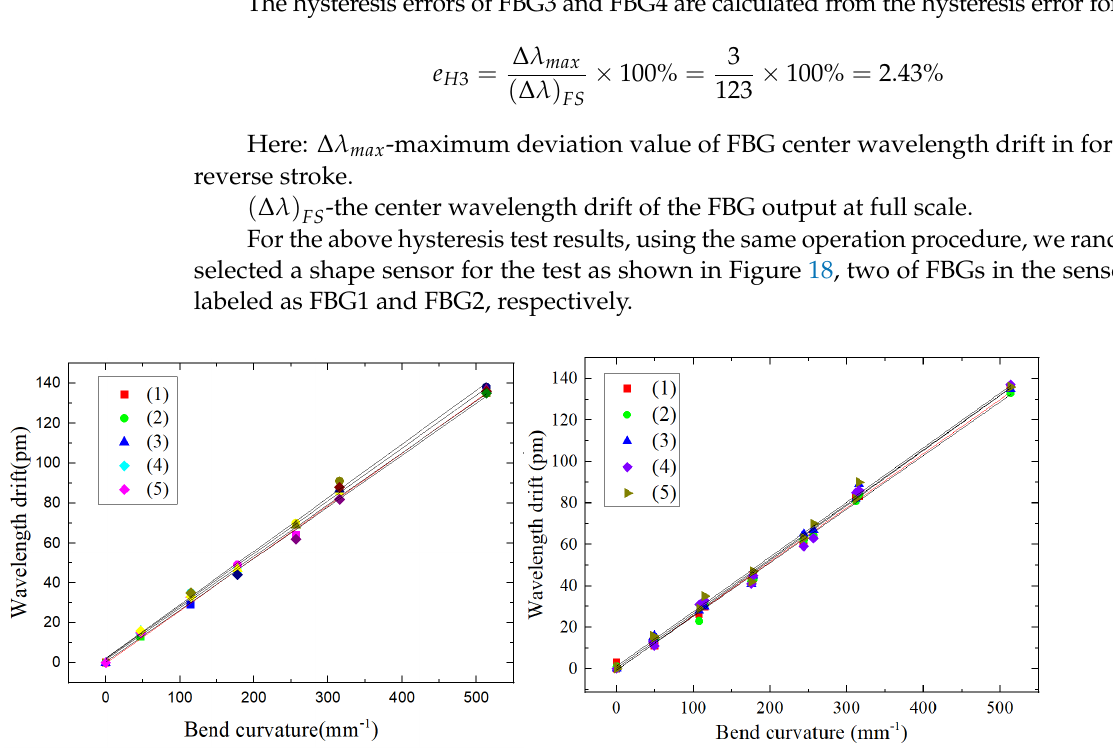
Figure 17. Shape sensor FBG hysteresis error analysis: ( a ) FBG3 center wavelength drift in forward-reverse stroke, ( b ) FBG4 center wavelength drift in forward-reverse stroke.